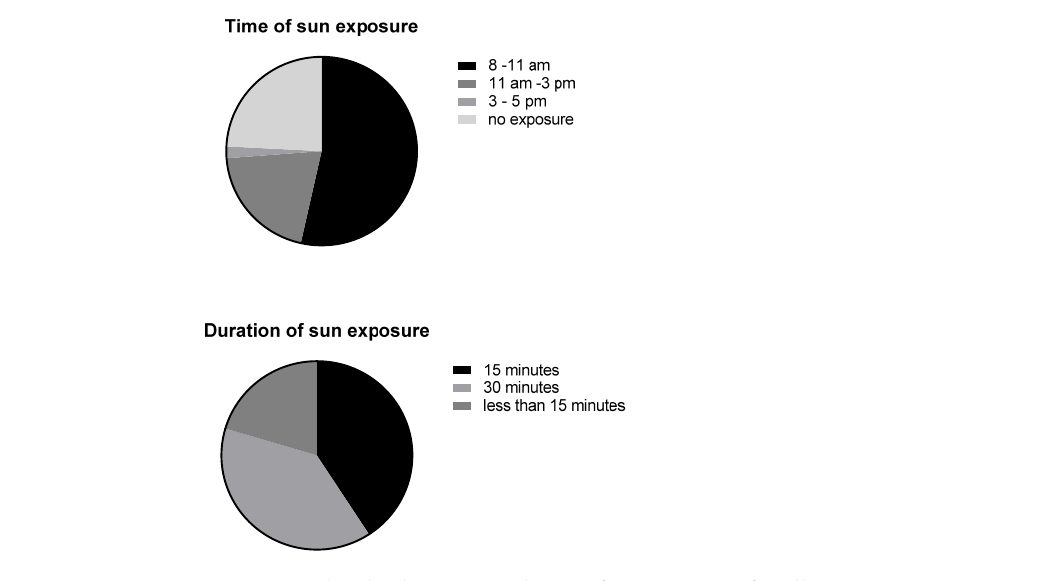
Figure 1. Veil style, duration, and time of sun exposure for all participants.